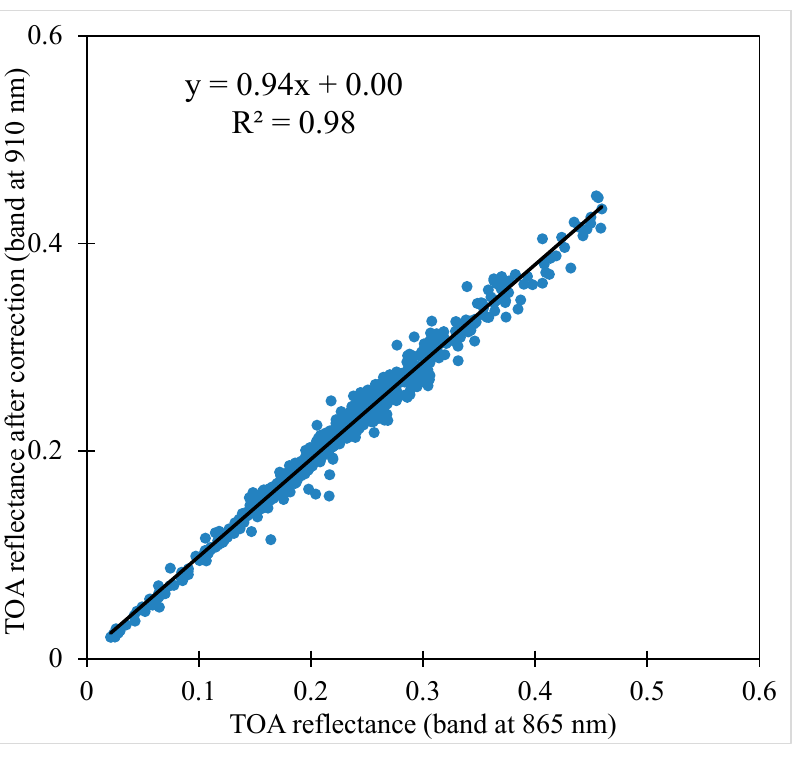
Figure 7. Comparison between DPC TOA reflectance in the 865 nm band and DPC TOA reflectance in the 910 nm band after water vapor absorption correction. The correction is implemented using 6SV with AERONET PWV as input.